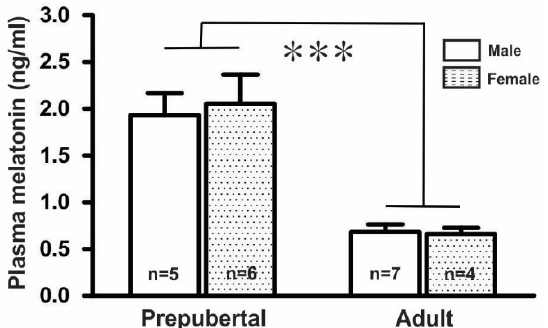
Figure 1. Mean plasma melatonin levels in C57BL/6 mice ( n = 4 to 7 in each group, *** p < 0.001; unpaired t -test). n , the number of mice.